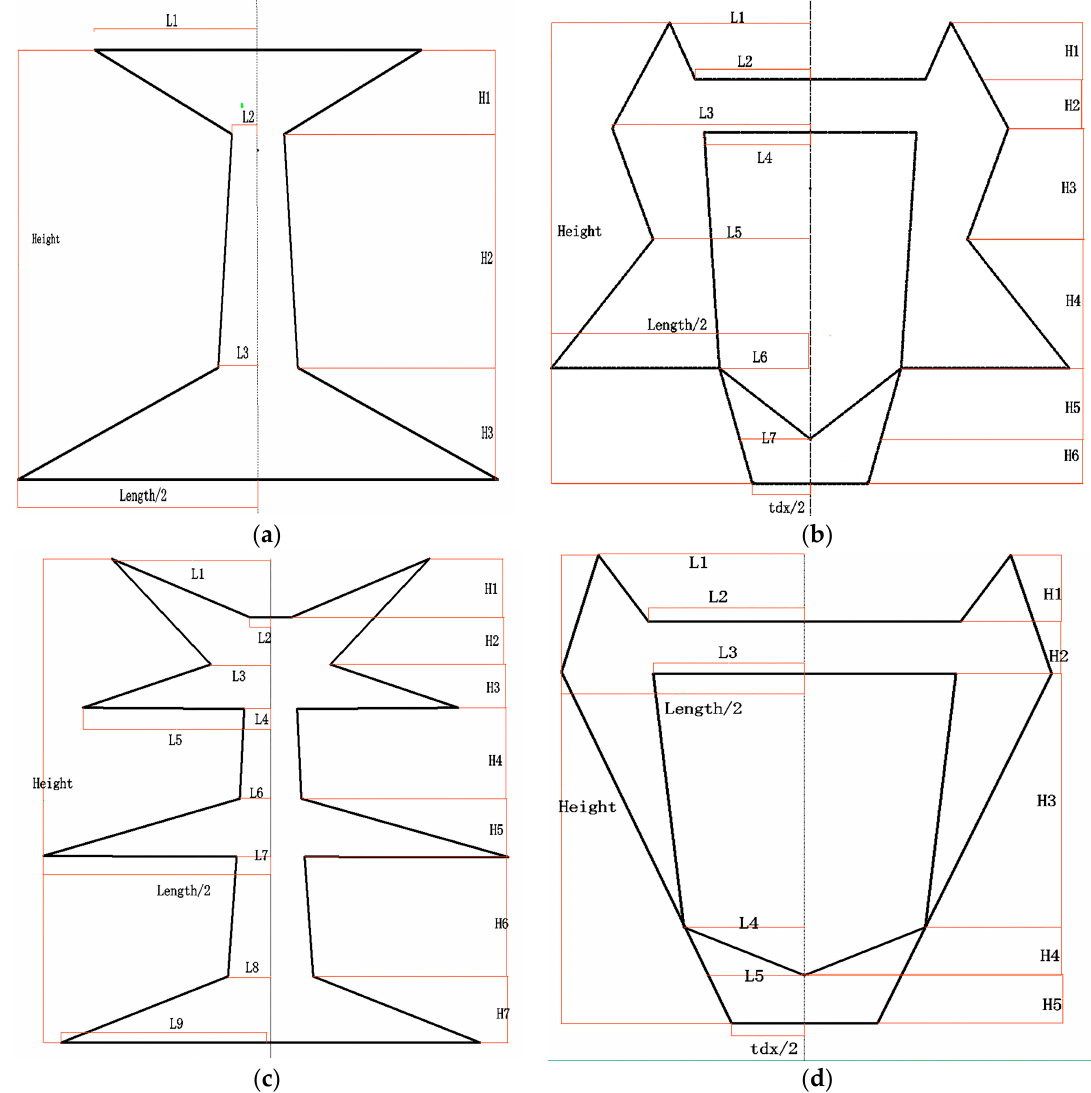
Figure 6. 3D parametric model library of pylon heads. The parameters are specified as the feature height, feature length and feature width. ( a ) Model 1; ( b ) Model 2; ( c ) Model 3; ( d ) Model 4.